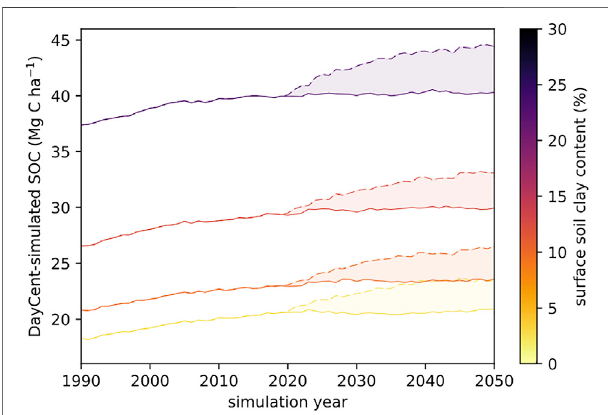
FIGURE 4 | Representative soil carbon modeling results for the climate- smart no-till establishment scenario, showing four randomly selected simulation strata. The solid lines show SOC trends under the business-as- usualcotton – cotton – peanutreferencerotationforeachstratum,withthe underlying soil texture indicated by color. Carinata integration starts in 2020 and results in an increasing SOC trend (dashed lines).